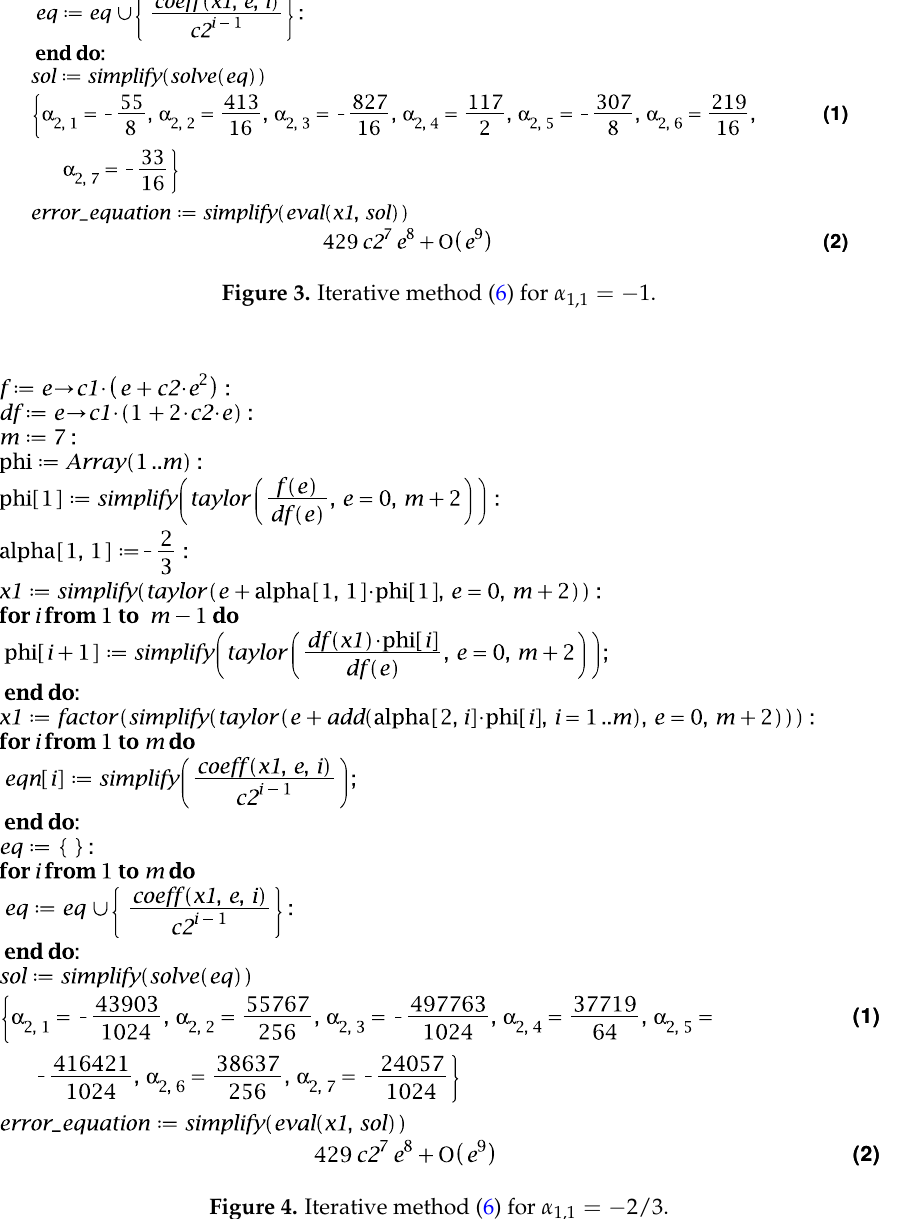
Figure 4. Iterative method (6) for α 1,1 = −